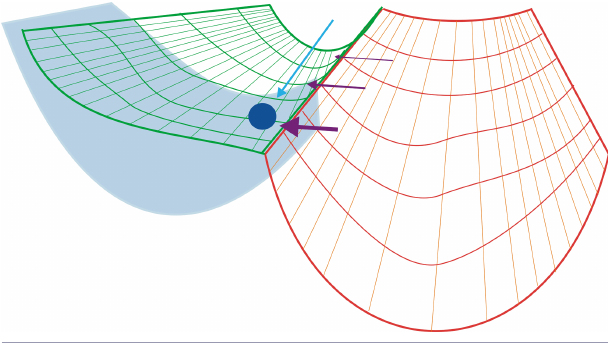
Fig. 1 . Illustration of coerced resilience. Shown are changes over time (blue arrow) of a desired (green) and undesired (red) regime. The shifting shapes of basins of attraction show that the desired regime becomes increasingly untenable while the undesired regime more stable over time. Increasing management intervention (purple arrows) are needed to coerce the system (symbolized with ball) into the ghost of a desired regime past (gray area warping the no longer existent basin of attraction and steep slopes leading into the undesired basin of